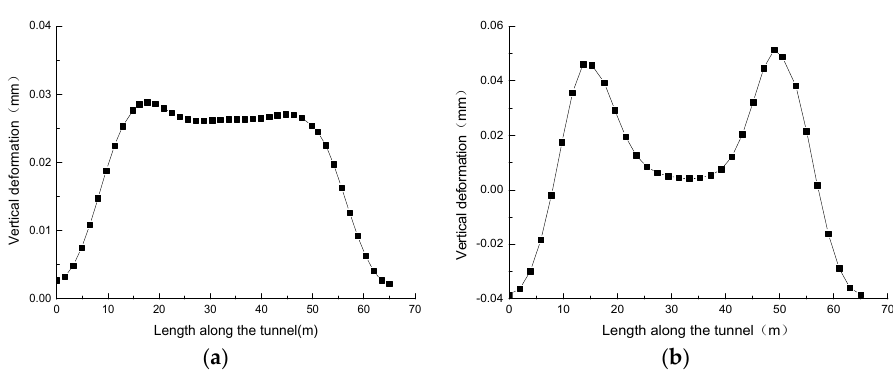
Figure 16. Vertical deformation of the vault. ( a ) Left line tunnel vault; ( b ) Right line tunnel vault.